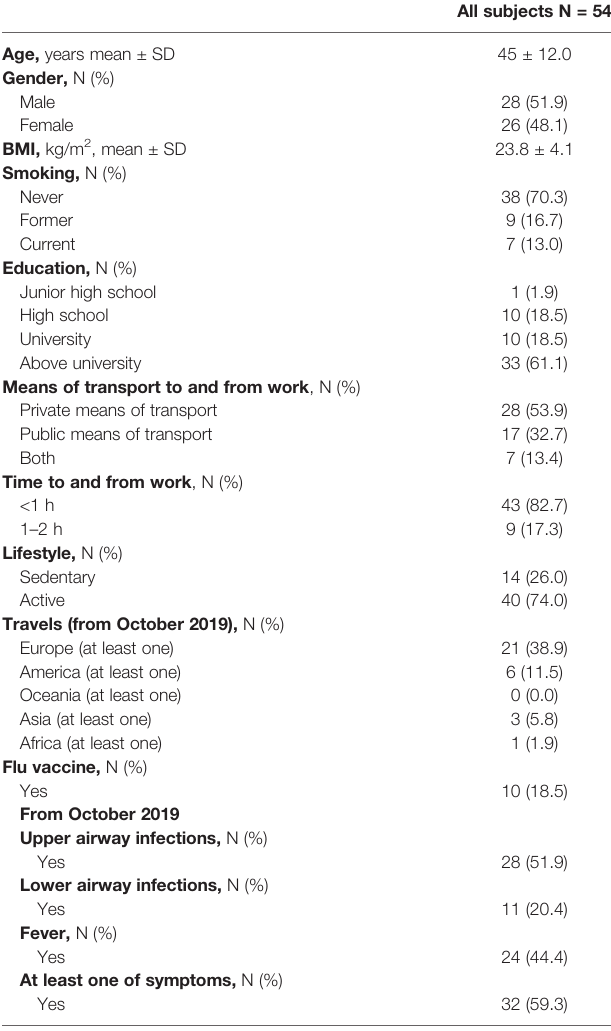
TABLE 2 | Characteristics of the study